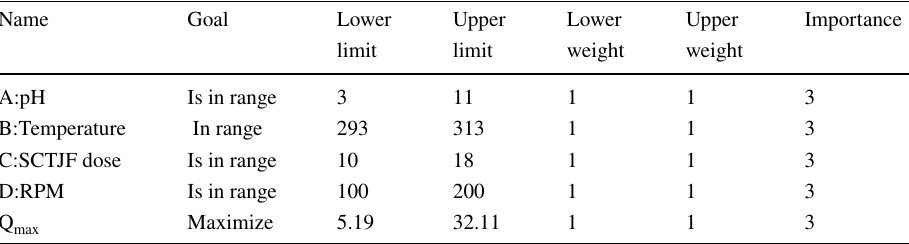
Table 8 Desirability responses based on range of input